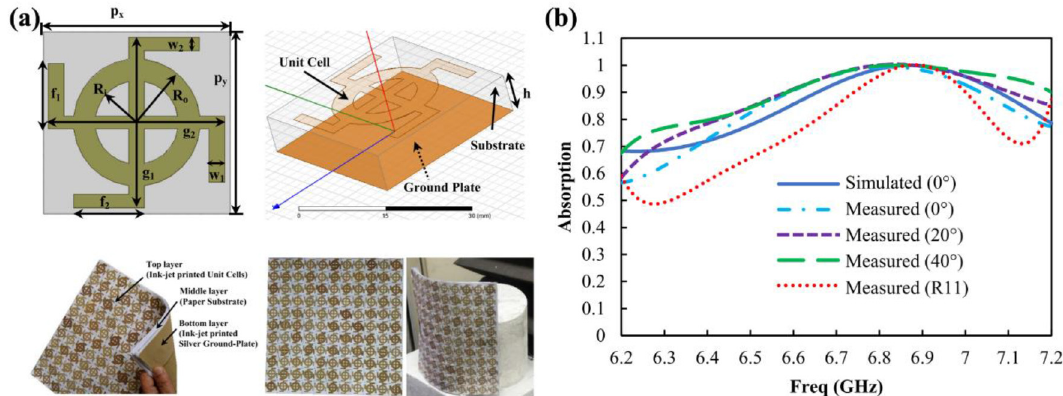
Fig. 1. (a) Schematic diagram and photograph of the ink-jet printing paper-based metamaterials. (b) Simulated and measured absorptivity at different incident angles on a planar surface, and at 0 ° on a cylindrical surface (R11) [61]. Reproduced with permission from M. Momeni-Nasab et al., Int. J. Electron. Commun. 123 , 153259 (2020). Copyright 2020 Elsevier. (This fi gure is subject to